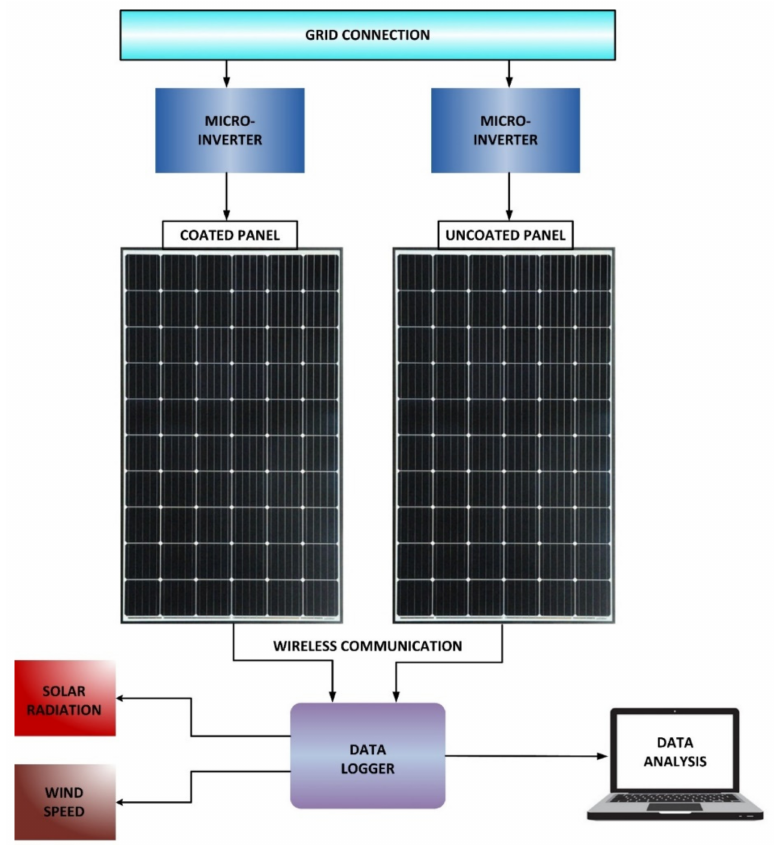
Figure 3. Schematic diagram showing the main parts of the experimental PV module